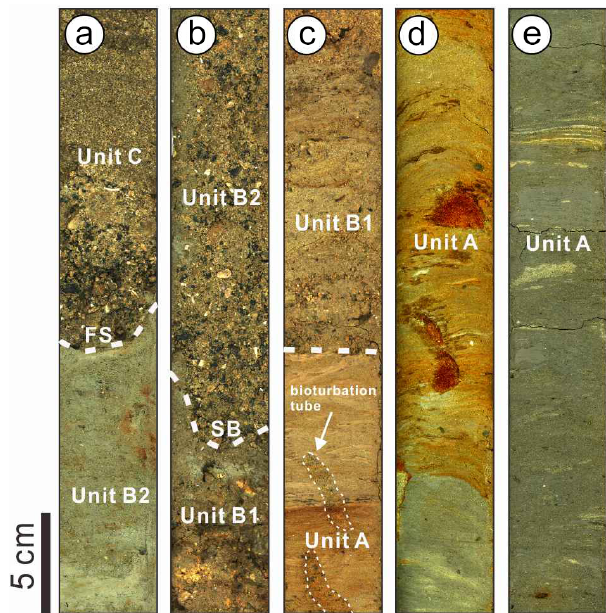
Figure 10. Selected photographs of sediments in core DSR-C03 in Fig. 9. (a) Massive mud-free sand beds with laminated sand, peb- ble, and shell-rich layers (Unit C). (b) Muddy coarse-grained sed- iments with weakly oxidized poorly sorted gravel and sand (Unit B2). (c) Completely oxidized poorly sorted gravel and sand without muddy sediments (Unit B1). (d, e) Moderately bioturbated, lami- nated, sandy mud, and muddy sand with moderate flaser, wavy to lenticular bedding, and rhythmic lamination (Unit A). The oxidized upper part of Unit A is reddish, while the lower part has a gray color. TRS: transgressive ravinement surface; SB: sequence